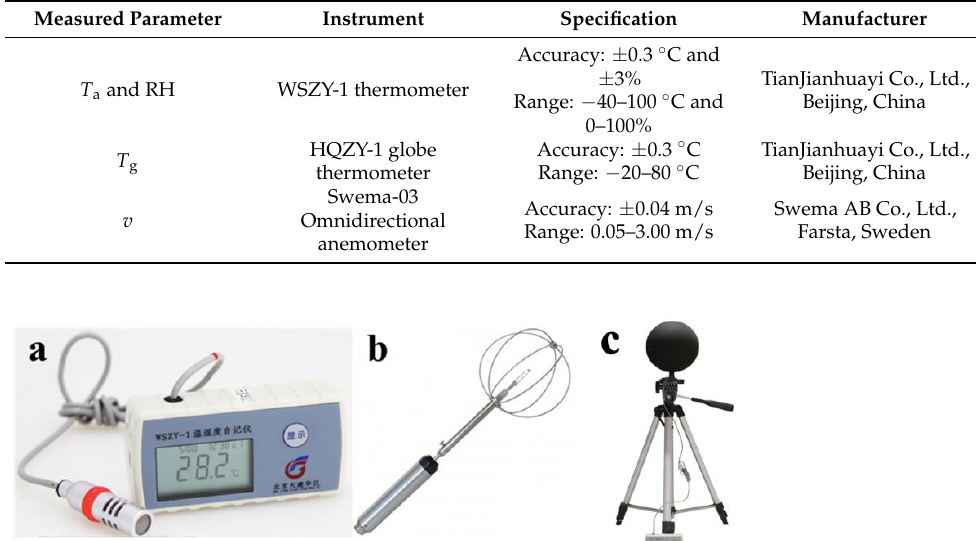
Table 4. Information on the instruments.